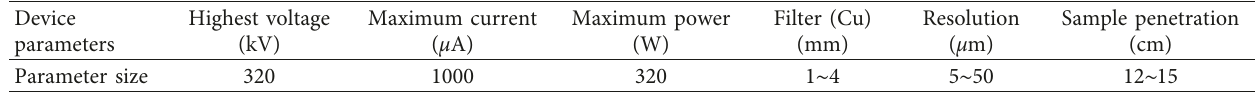
Table 2: XTH320 series X-ray three-dimensional microscope equipment performance